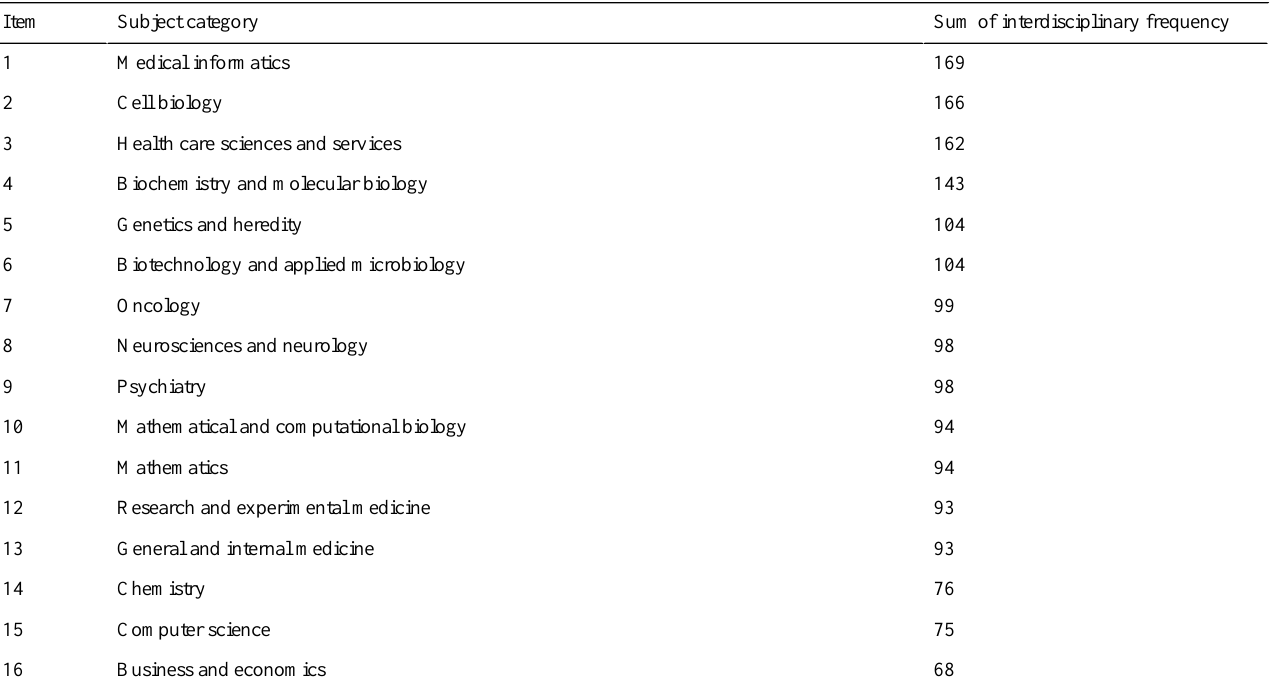
Table 2. Disciplines with co-occurrence frequency equal to or greater than 30.